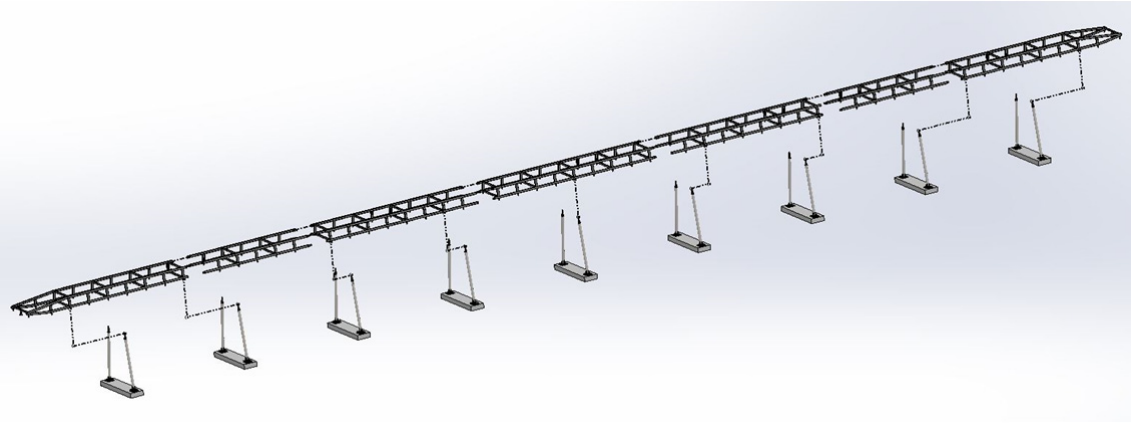
Fig. 2 Load bearing system of main steel structure.